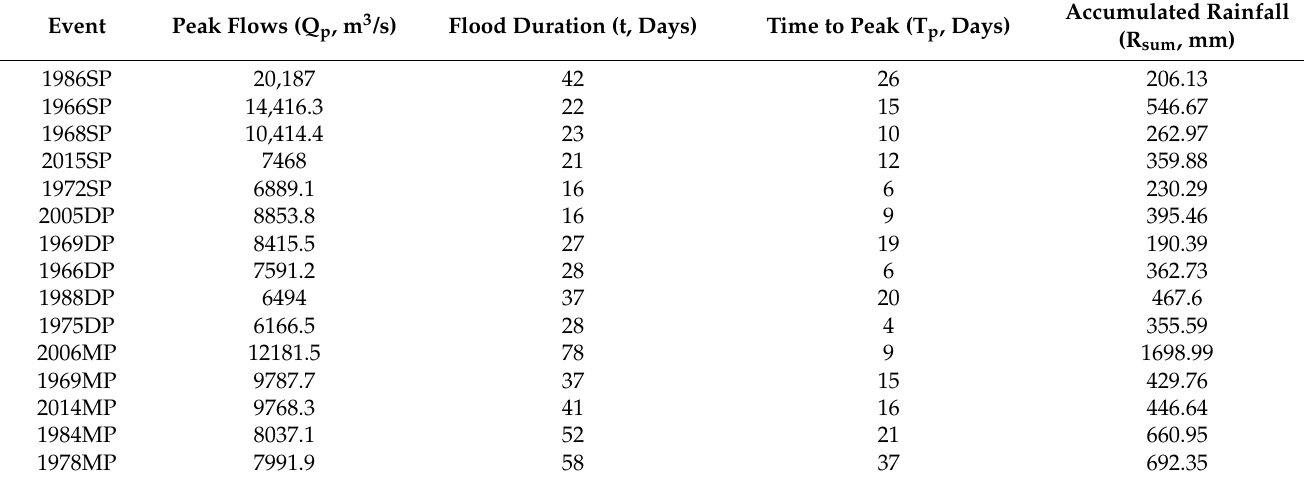
Table 1. Flood aspects at Konta GD station, i.e., peak flows (Qp), flood duration (t), time to peak (Tp) and accumulated rainfall (Rsum) for the selected 15 events used in the model’s calibration. The letters in the event name, i.e., SP, DP and MP, correspond to single-, double- and multiple-peak, respectively.